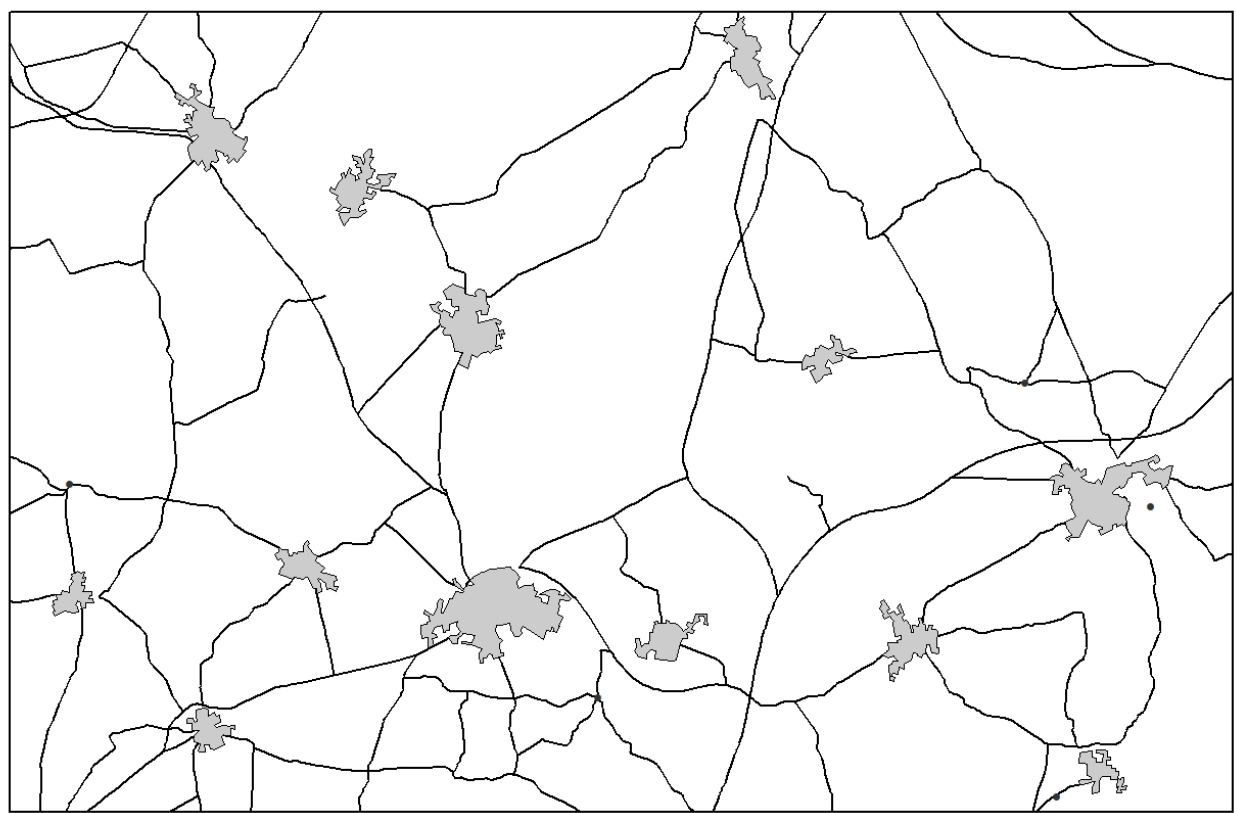
Figure 9. Initial road network and built areas (no generalization applied) at scale 1: 250,000.